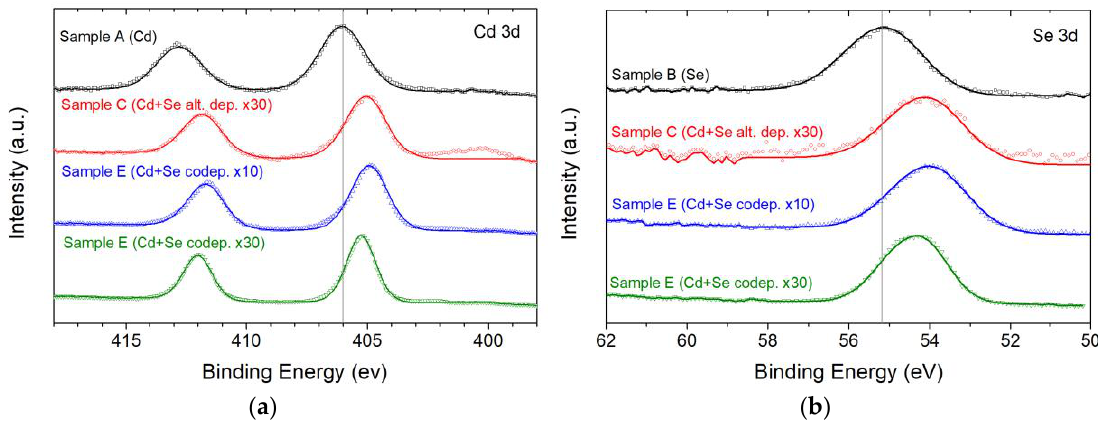
Figure 8. XPS analysis of the five samples: ( a ) High-resolution spectra of the Cd 3d zone (sample A, C, D and E); ( b ) high-resolution spectra of the Se 3d zone (sample B, C, D and E).